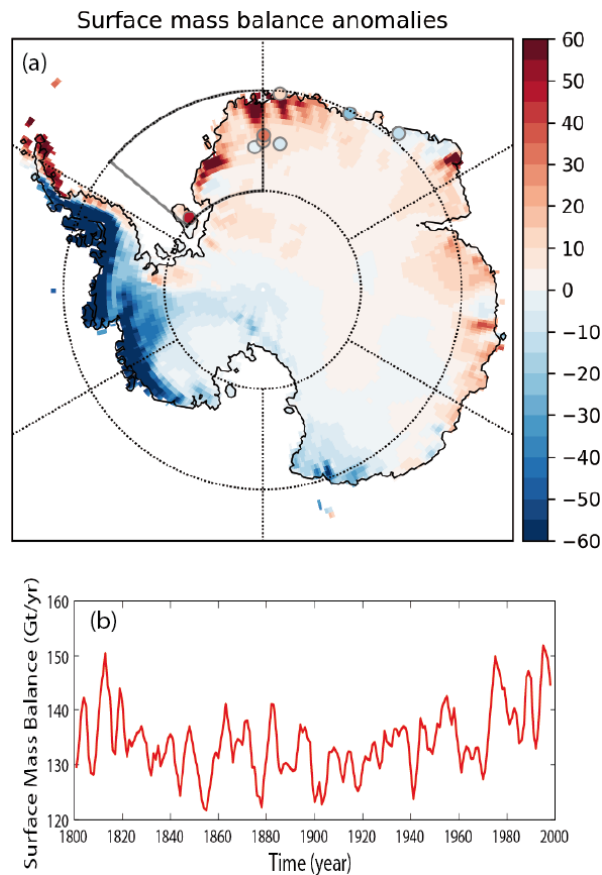
Figure 3. (a) Anomaly of SMB (mm w.e.yr − 1 ) averaged over 1974–1976 compared with the 1958–2000 period in the Medley and Thomas (2019) reconstruction. The dots correspond to the estimates from the ice cores in Table 1. In the figure, the B40 core has been shifted northward by 0.6 ◦ in order to avoid a overly large overlap with nearby cores. (b) SMB (Gtyr − 1 ) integrated over the grounded ice sheet between 50 ◦ W and 0 ◦ E, north of 80 ◦ S (box in panel a ) in Medley and Thomas (2019) reconstruction. A 3-year running mean has been applied to the